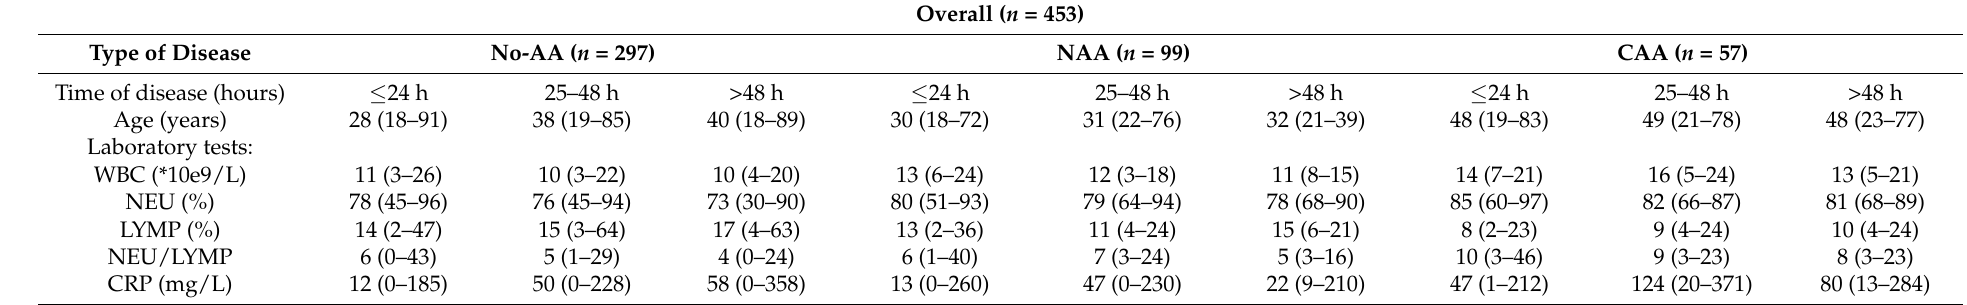
Table 2. Demographic and clinical characteristics of patients according to three main time intervals from the onset of the disease.